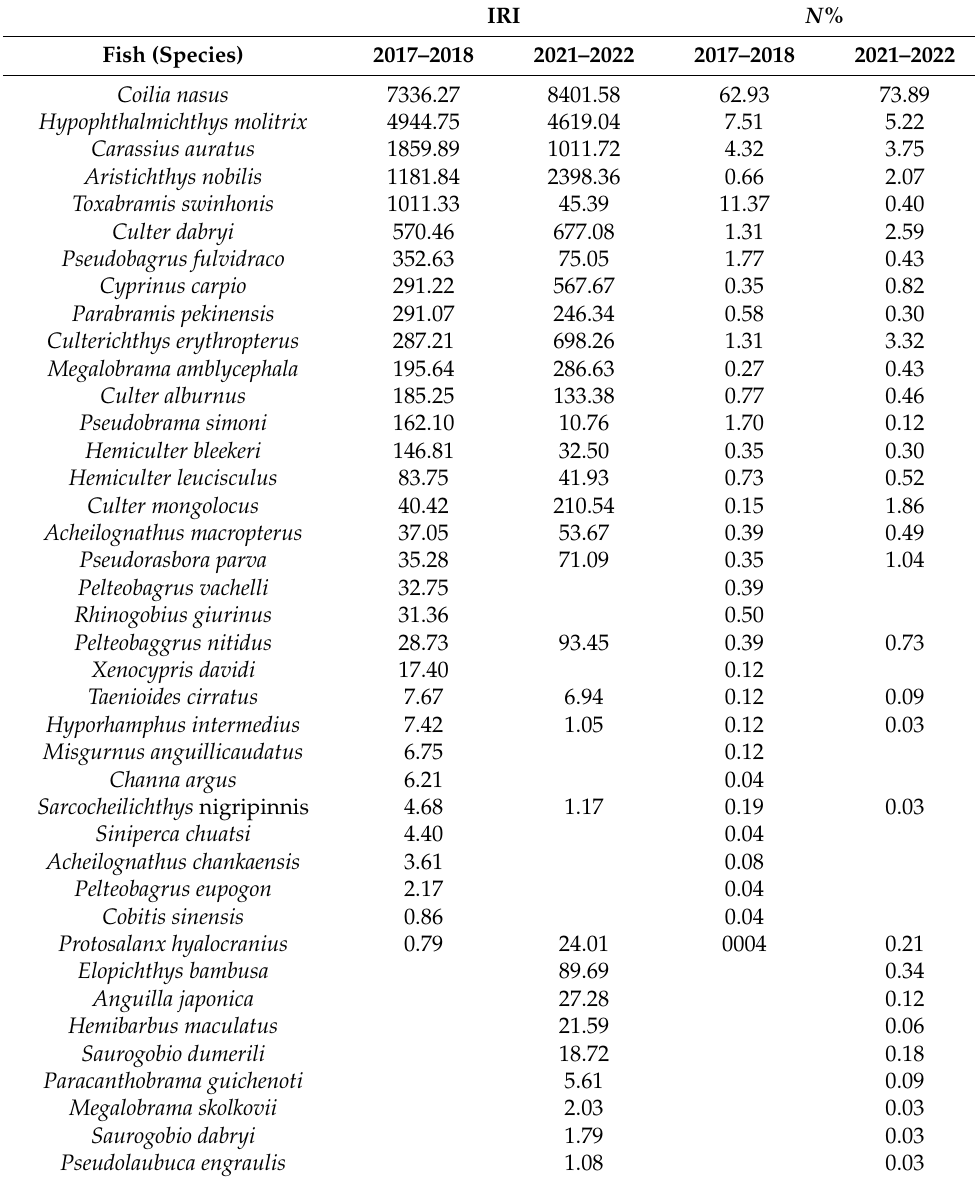
Table 4. Comparison of IRI and N % of fish in the seine area of the southern part of Gehu Lake